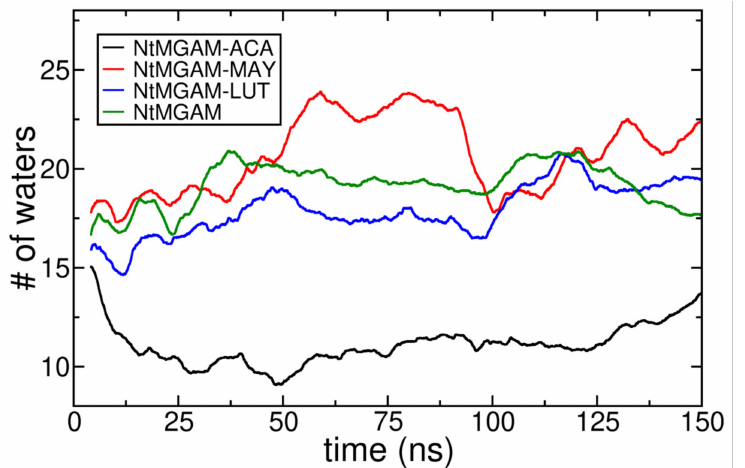
Figure 8. Number of water molecules within a distance of 6 Amstrongs from the Asp443 residue, this graph shows how the number of waters decreases in ACA compared to the control protein, unlike MAY which increases the number of waters.